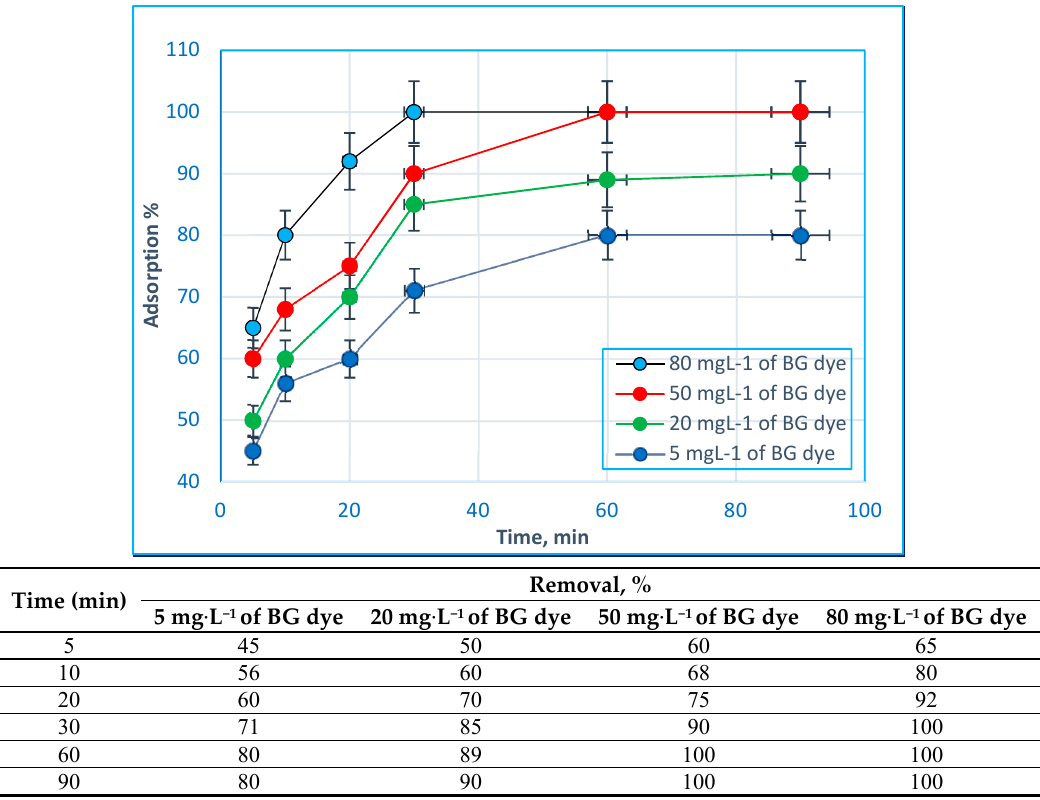
Figure 6. Influence of pH on the adsorption of brilliant green (BG) dye by Hap/CS nanocomposite.